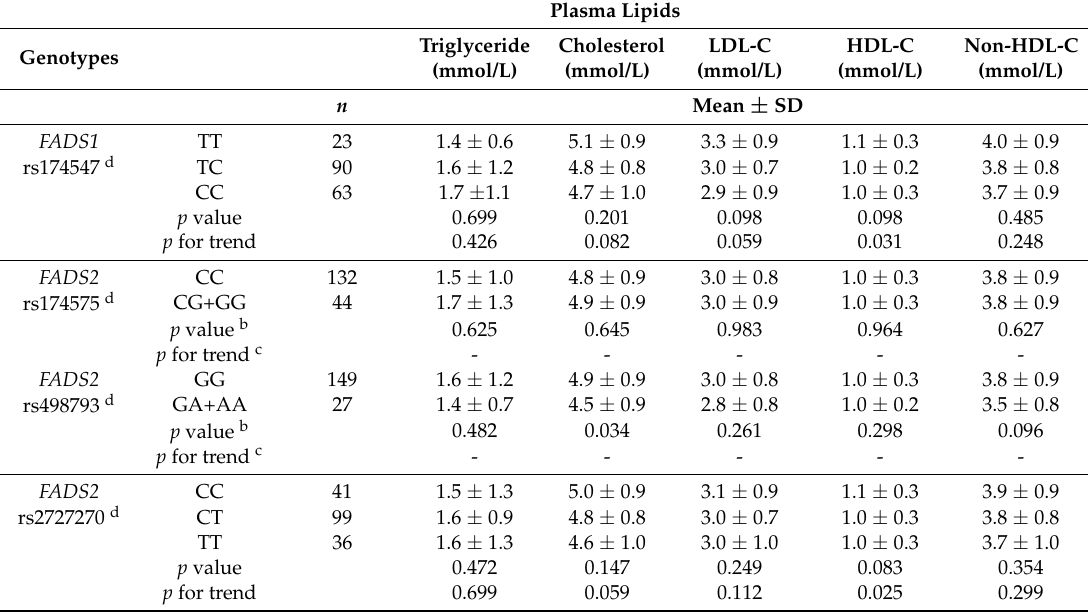
Table 4. Differences of plasma lipid concentrations among FADS1 and FADS2 genotypes in type 2 diabetes patients ( n = 176). a